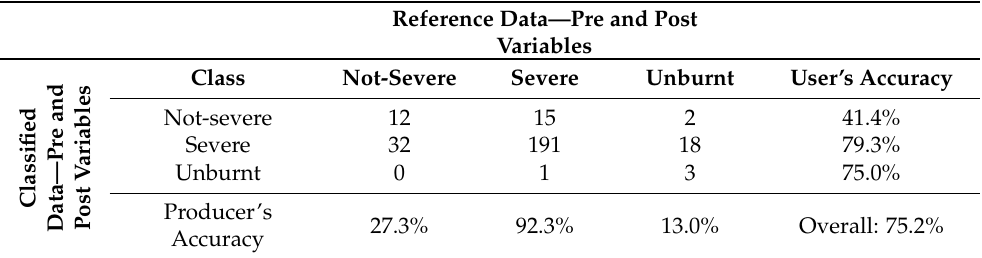
Table 9. Confusion matrix for LiDAR-only data stream describing severity of low vegetation segments.